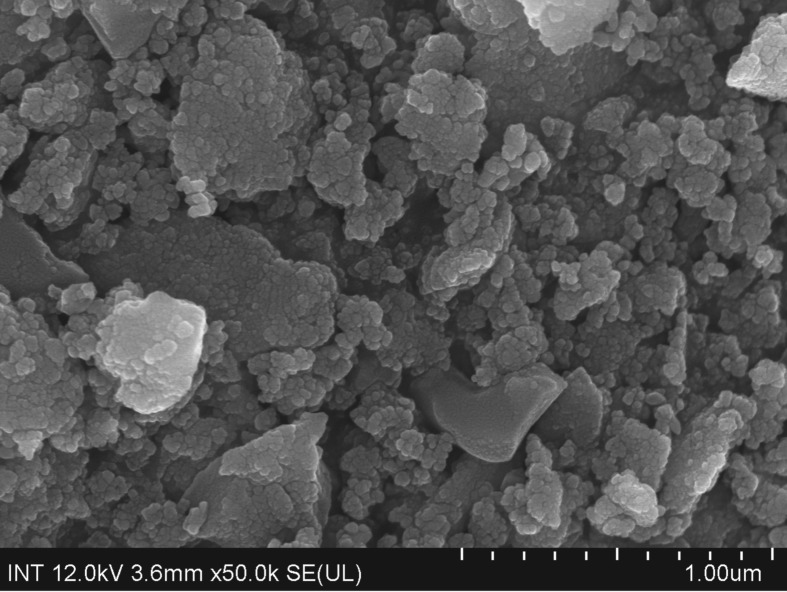
SEM micrograpth of the La0.6Sr0.4CoO3 perovskite catalyst.